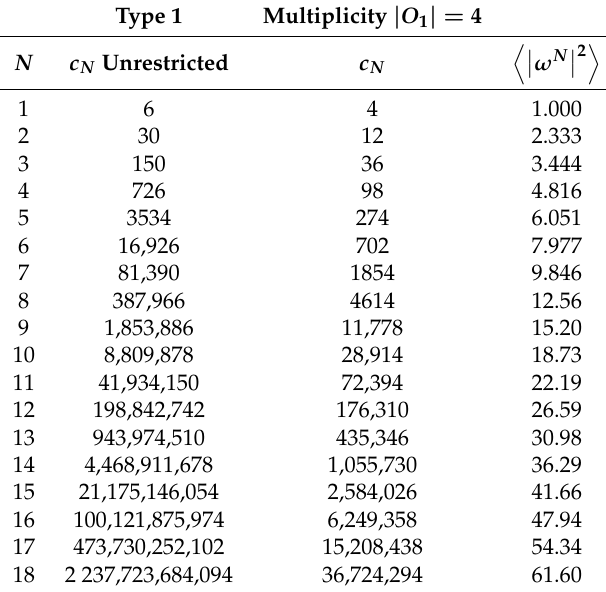
Table A1. SC lattice, tube cross section 1.0 × 1.0. The second column of the first table is the value of c N for SAWs on the unrestricted SC lattice, included for comparison purposes.